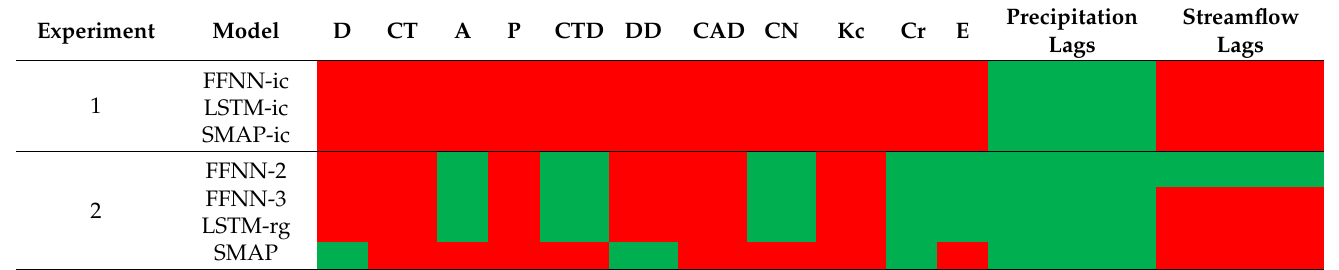
Table 2. Representation of models’